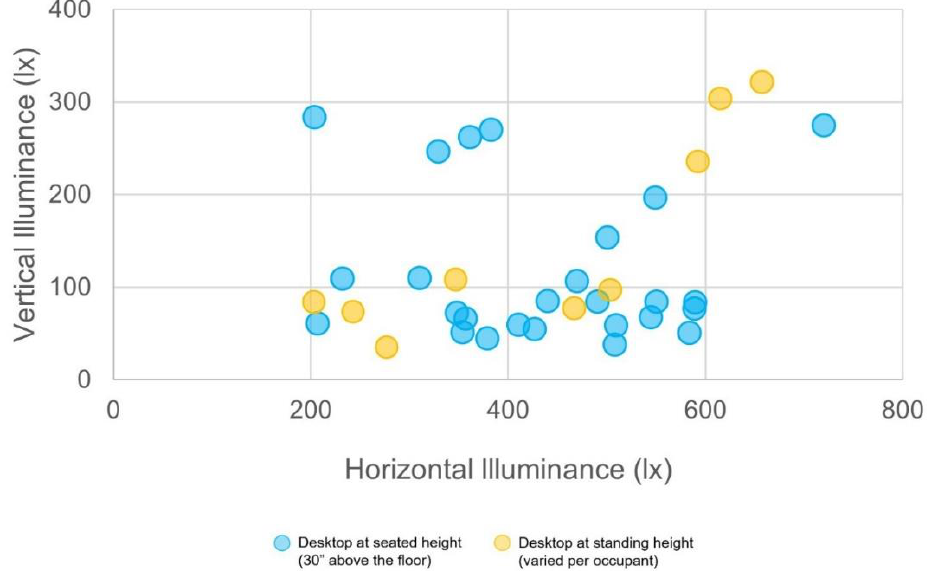
Figure 3. Vertical and horizontal illuminance measurements at desk locations at 90% output. Twenty- five of the thirty-five workstations receive less than 150 lx in the vertical plane under the 90% 3500 K lighting condition. However, horizontal illuminance varies between 203 and 589 lx for the same 25